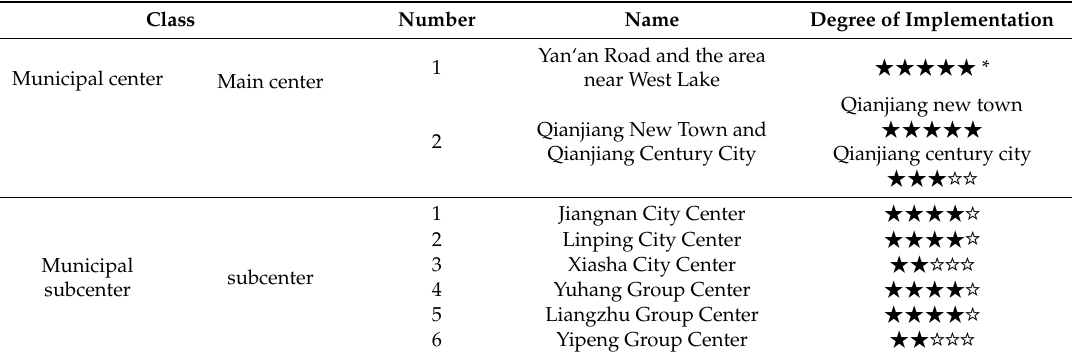
*: The stars express the degree of implementation. One star and five stars correspond to the lowest and the highest degree of implementation respectively.